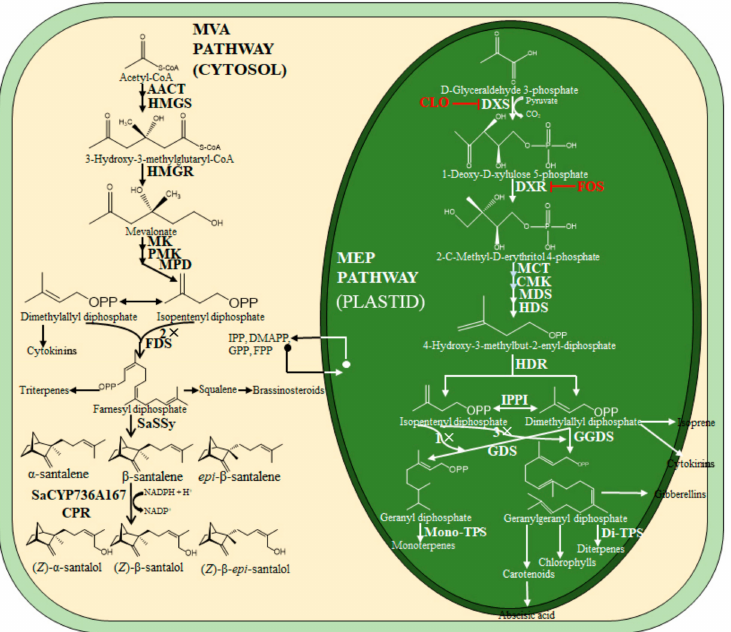
Figure 1. Outline of the MVA and MEP pathways in plants, and the biosynthesis of santalol, chloro- phylls and carotenoids in S. album . DXR was inhibited by fosmidomycin (FOS), which is shown in red. Cytosol: AACT, acetoacetyl-CoA thiolase; FDS, farnesyl diphospate synthase; HMGR, 3- hydroxy-3-methylglutary-CoA reductase; HMGS, 3-hydroxy-3-methylglutary-CoA synthase; MK, mevalonate kinase; MPD, mevalonate-5-diphosphate decarboxylase; MVA, mevalonate acid; PMK 5-phosphate-mevalonate kinase. Plastid: CMK, 4-cytidine 5 (cid:48) -diphospho-2-C-methyl-D-erythritol kinase; DMAPP, dimethylallyl diphosphate; DXP, 1-deoxy-D-xylulose-5-phosphate; DXR, 1-deoxy- D-xylulose-5-phosphate reductase; DXS, 1-deoxy-D-xylulose-5-phosphate synthase; GDS, geranyl diphosphate synthase; GGDS, geranylgeranyl diphosphate synthase; GGPP, geranylgeranyl diphos- phate; GPP, geranyl diphosphate; HDR, 1-hydroxy-2-methyl-2-(E)-butenyl-4-diphosphate reductase; HDS, 1-hydroxy-2-methyl-2-(E)-butenyl-4-diphosphate synthase; IPPI, isopentenyl diphosphate isomerase; MCT, 2-C-methyl-D-erythritol 4-phosphate cytidylyltransferase; MEP, 2-C-methyl-D-